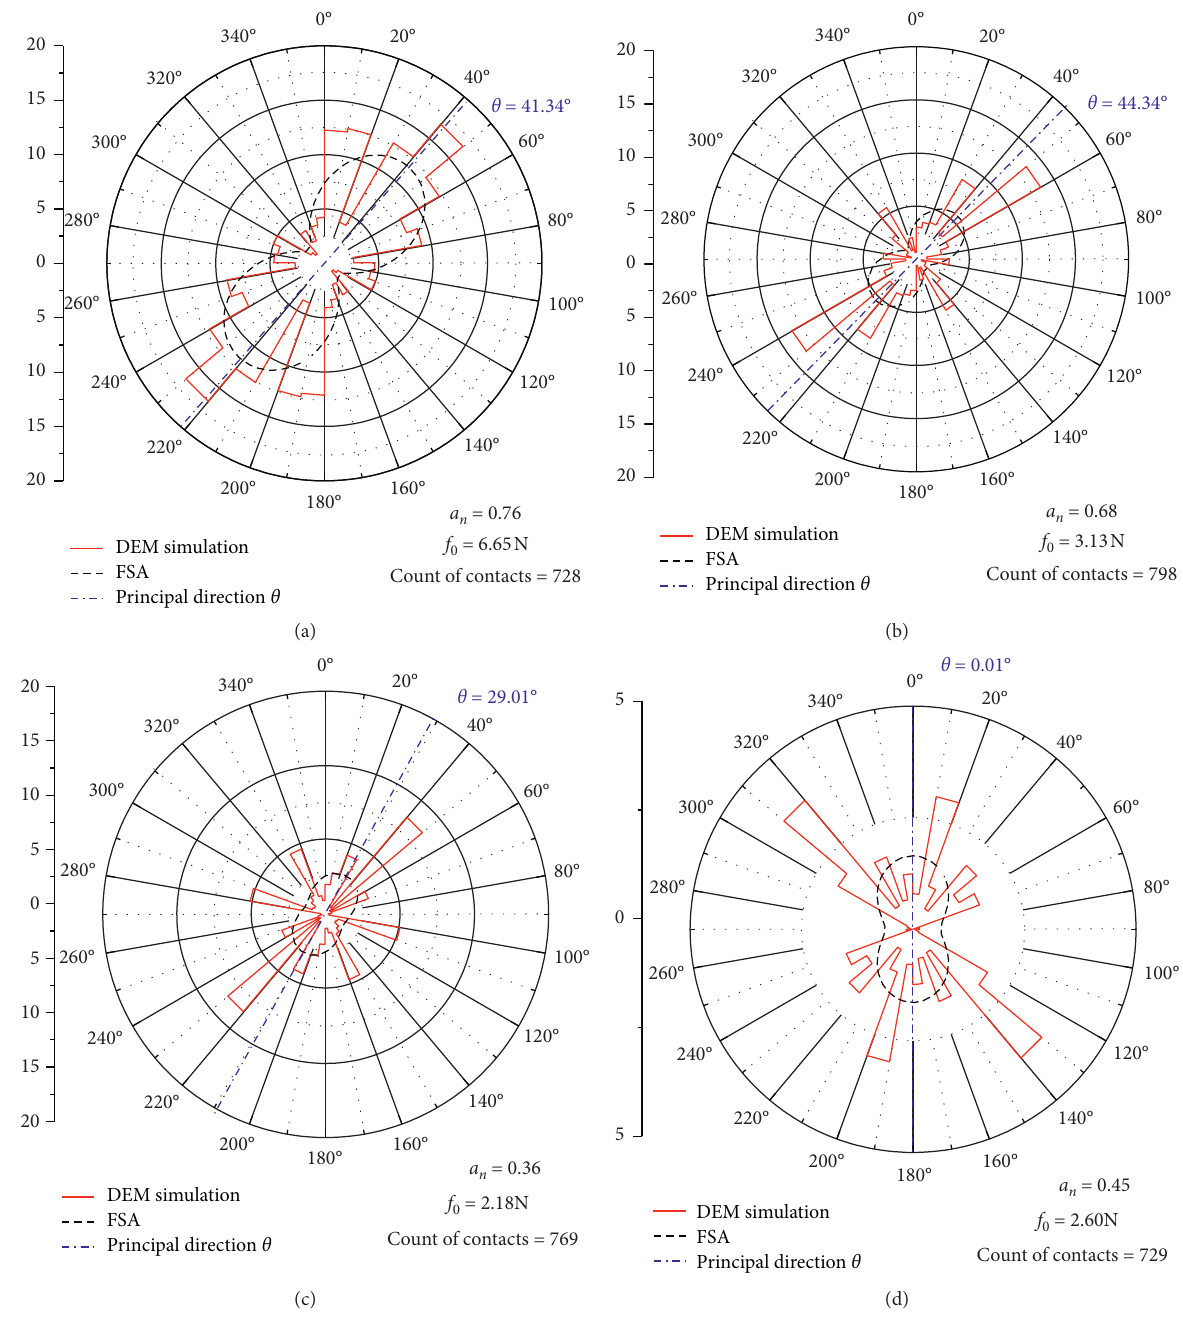
Figure 9: Polar plots and FSA of projection of normal contact force on y - o - z plane in four statistical zones of BG1 (normal stress � 20kPa; pull-out displacement � 36 mm): (a) statistical zone 1; (b) statistical zone 2; (c) statistical zone 3; (d) statistical zone